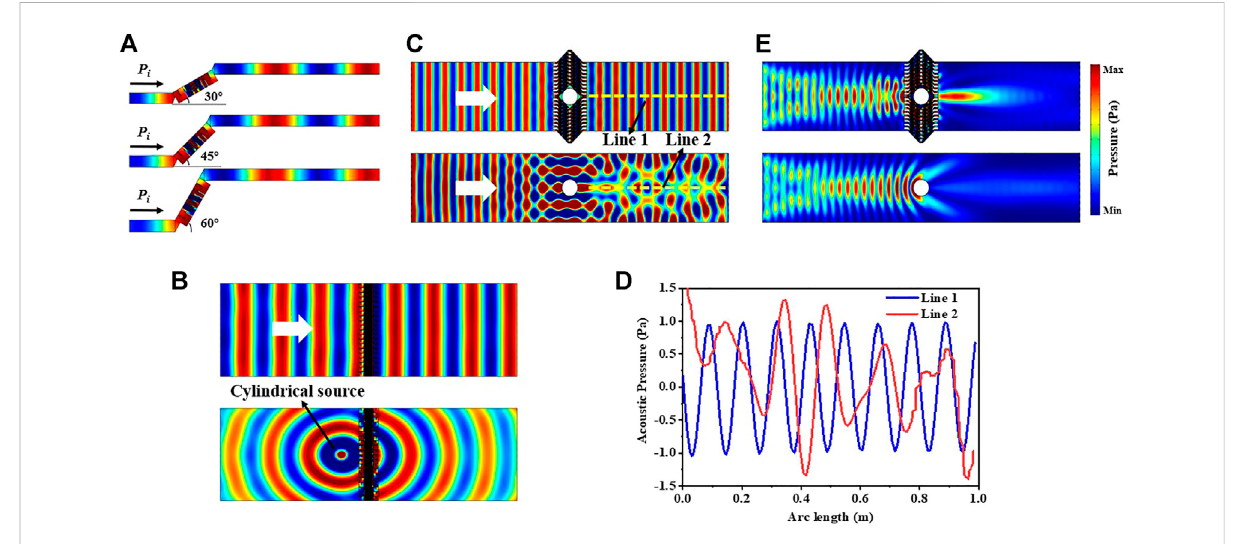
FIGURE 2 Acoustic pressure distributions of (A) the waveguide designed by LS with different rotation angles, (B) the array of LS stimulated by plane and cylindrical sources, and (C) the circular scattering body surrounded by LS array and without LS array at 3,430 Hz. (D) Acoustic pressure distributions alongLines one and2markedbyyellow dashedlinesinPanel2C. (E) Acoustic intensity distributions ofthecircular scatteringbody surrounded byLS array and without LS array at 3,430